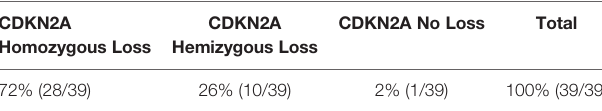
TABLE 6 | Homozygous, hemizygous and no loss of CDKN2A detected by droplet digital PCR (ddPCR) in malignant pleural mesothelioma (MPM) samples. CDKN2A Homozygous Loss